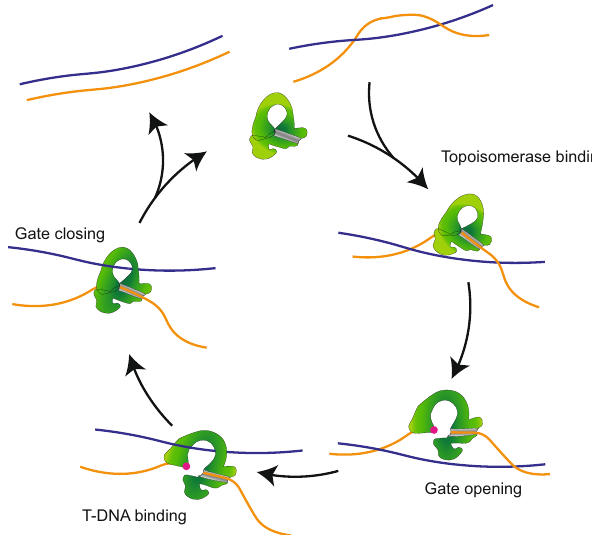
Fig. 1 Schematic representation of the catalytic cycle of type 1A topoisomerases. First (top right), the enzyme (green) binds in a closed con fi guration to a region of ssDNA (orange). The enzyme cleaves the ssDNA backbone upon binding and forms a protein-ssDNA gate (red dot indicates the catalytic site, which forms a covalent bond with the DNA backbone). The protein subsequently undergoes a conformational rearrangement that opens the gate. This allows an adjacent strand of T-DNA (blue) to bind to the protein cavity. Finally, the enzyme-ssDNA gate closes and the ssDNA backbone is re-ligated. For two entwined DNA strands, this cycle results in (de)catenation of the two